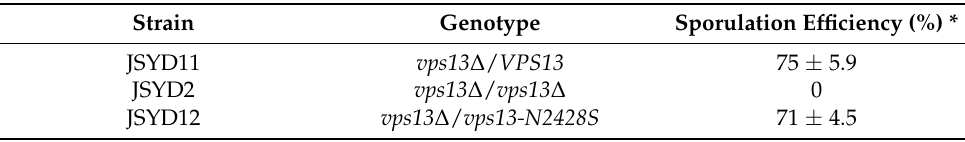
Table 2. Sporulation in vps13-N2428S compared to VPS13